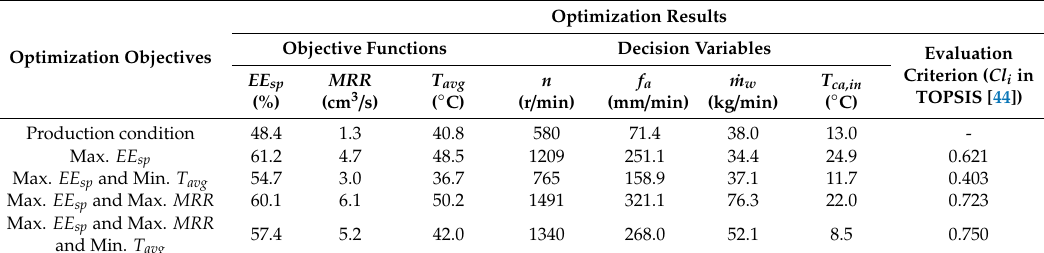
Table 3. Optimization results.